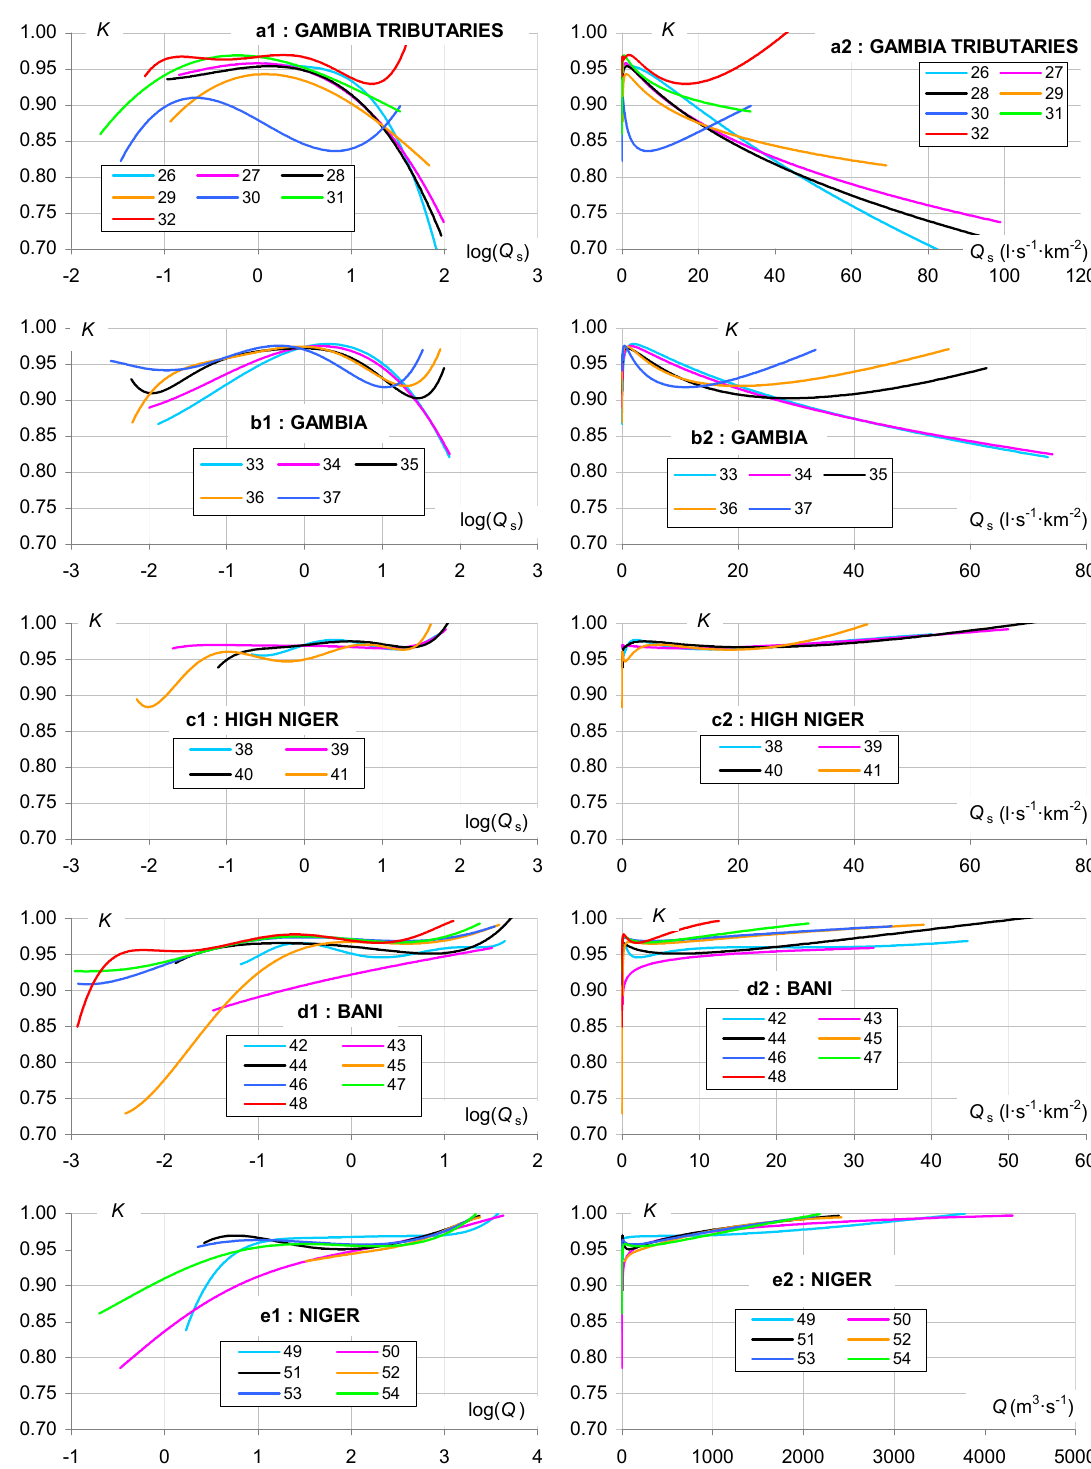
Figure 8. Model 2 representing K as a function of the specific discharge Q s or the discharge Q at stations 26 to 54 in the Gambia and Niger basins (relations K = g ( Q )), with abscissa in logarithmic values on the left (index 1) and natural values on the right (index 2), by sub-basins: Gambia tributaries ( a1 , a2 ), Gambia ( b1 , b2 ), High Niger ( c1 , c2 ), Bani ( d1 , d2 ), Niger ( e1 , e2 ).